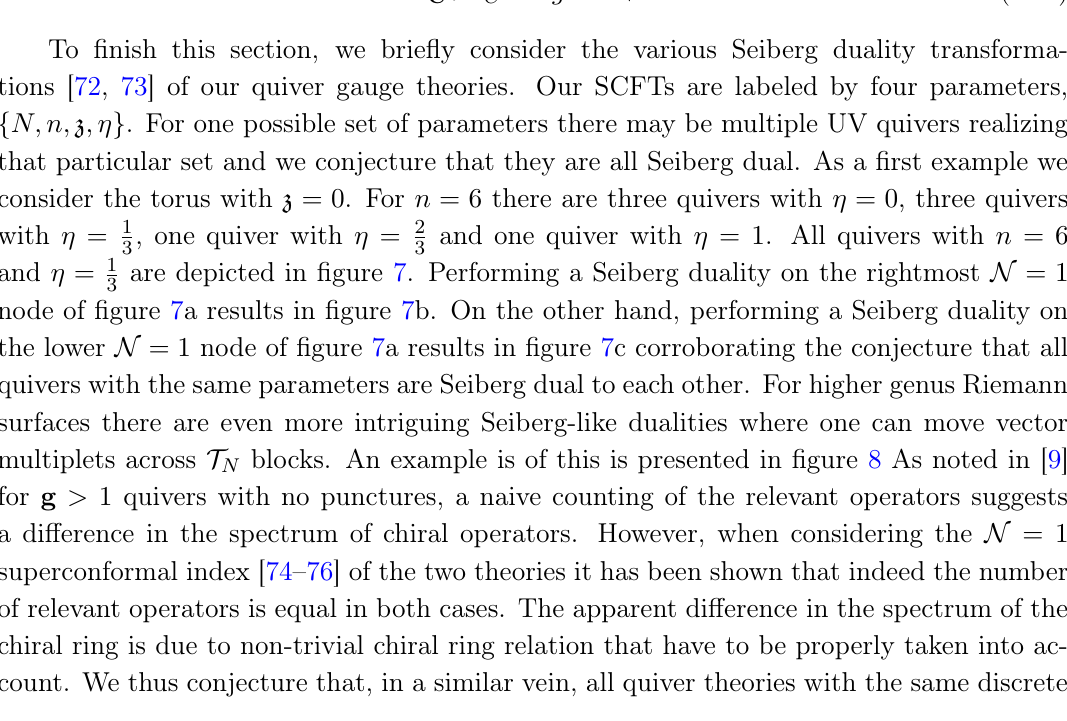
. At this point there are no 0